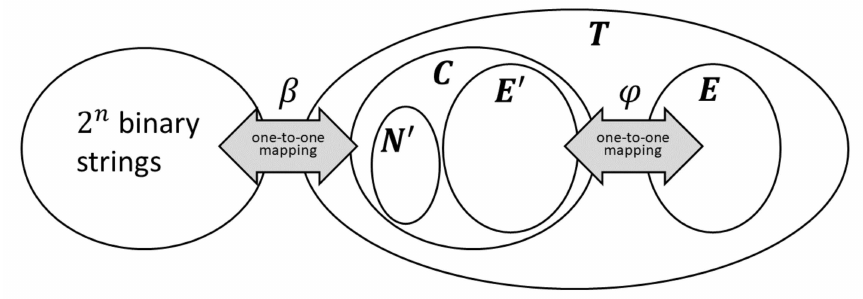
Figure 1. Relationship among the sets composed by the sequences of s symbols from the alphabet Ψ .